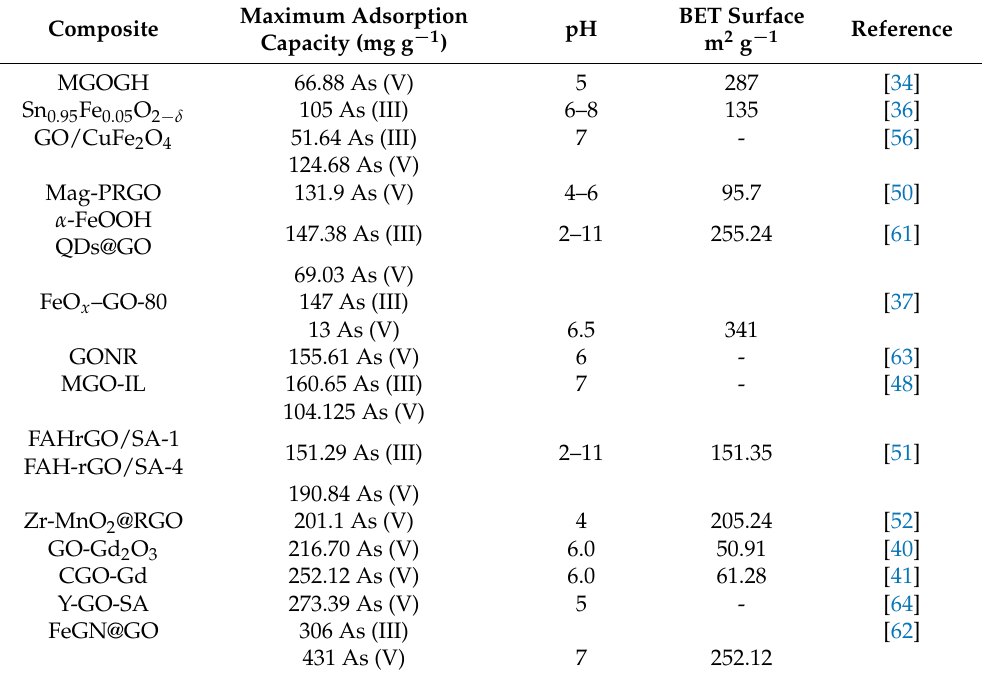
Table 1. Arsenic adsorption on GO nanofunctionalized